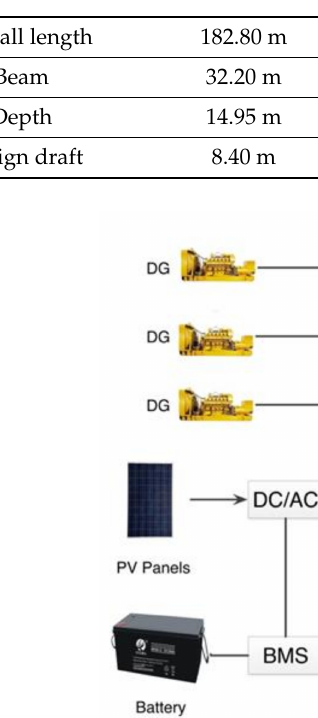
Table 1. The basic parameters of the roll-on roll o ff (ro-ro) ship.